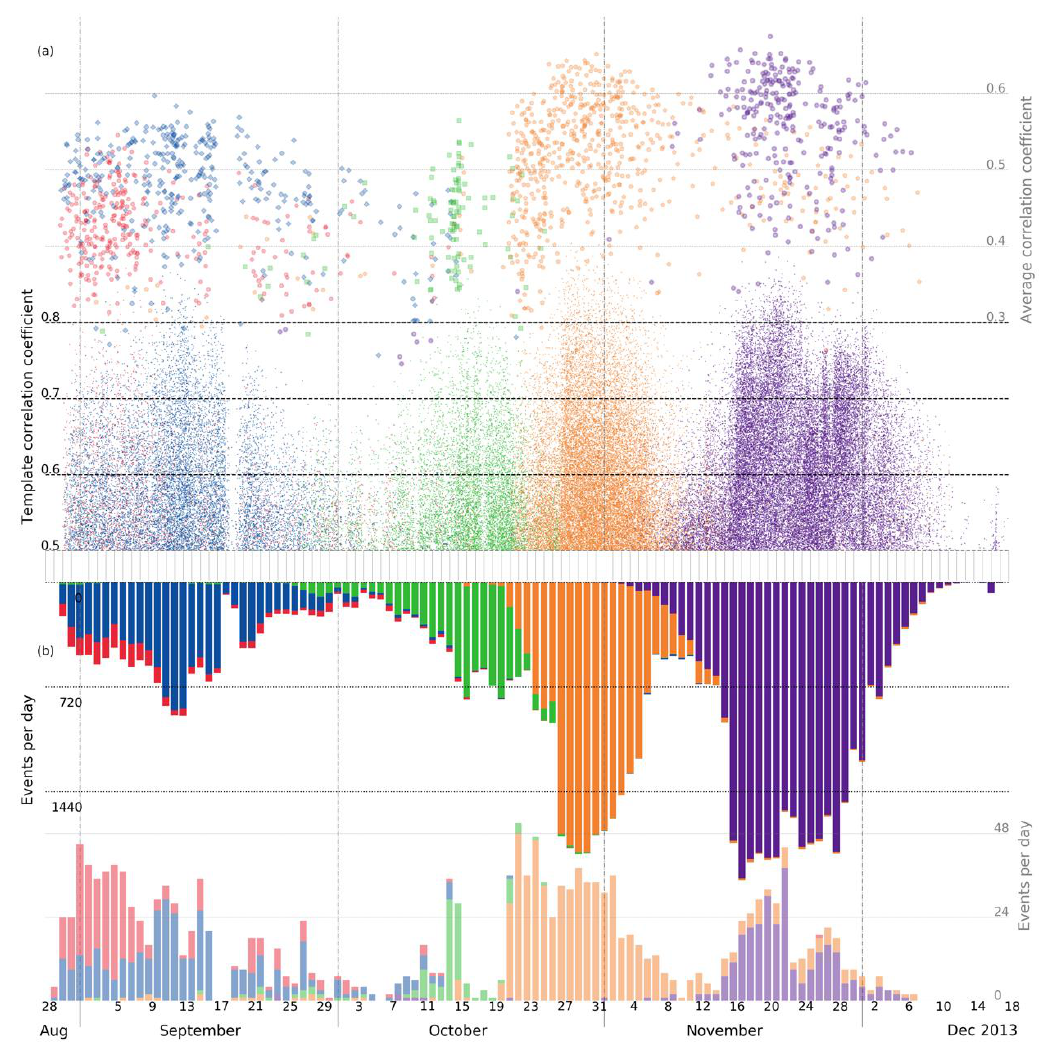
Figure 10. The MF-based catalog of lower-energy events in comparison with cluster analysis results for the BP-based catalog containing most-energetic earthquakes (in pale colors): ( a ) CCs for both catalogs (note that these are not the same type); ( b ) time distribution of the events’ daily amount.